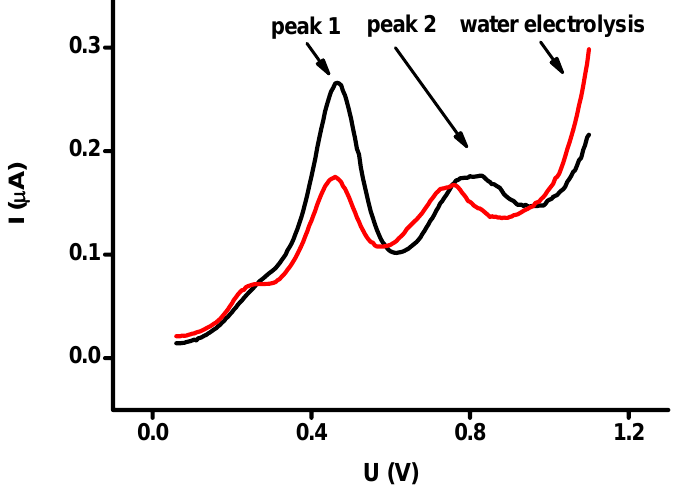
Figure 2. Comparison of FRAP and SWV from five vultures. Figures (a) and (b) represent the relation between peak 1 (466 ± 15 mV) and peak 2 (743 ± 30 mV) and FRAP values, respectively. Figure (c) represents a regression between the sum of peaks 1 and 2 and FRAP values. Error bars indicate standard error of mean for five time repeated